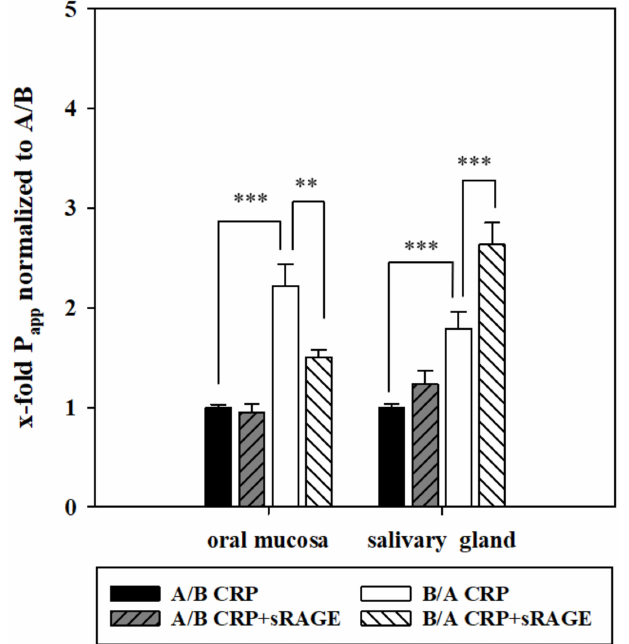
Figure 4. Apparent permeability (P app ) values of the oral mucosa and salivary gland model upon applying 10 µ g/mL CRP or 10 µ g/mL CRP + 5 µ g/mL sRAGE on the apical (A/B) or basolateral (B/A) side for 24 h. Results shown as mean ± SEM of two–six independent experiments (N = 7–24) upon normalization to P app CRP values from A/B. Outliers were excluded applying Grubb’s test. Statistical analysis was performed as two-way ANOVA, post-hoc Holm-Sidak test with α = 0.05, p < 0.01 **, p < 0.001